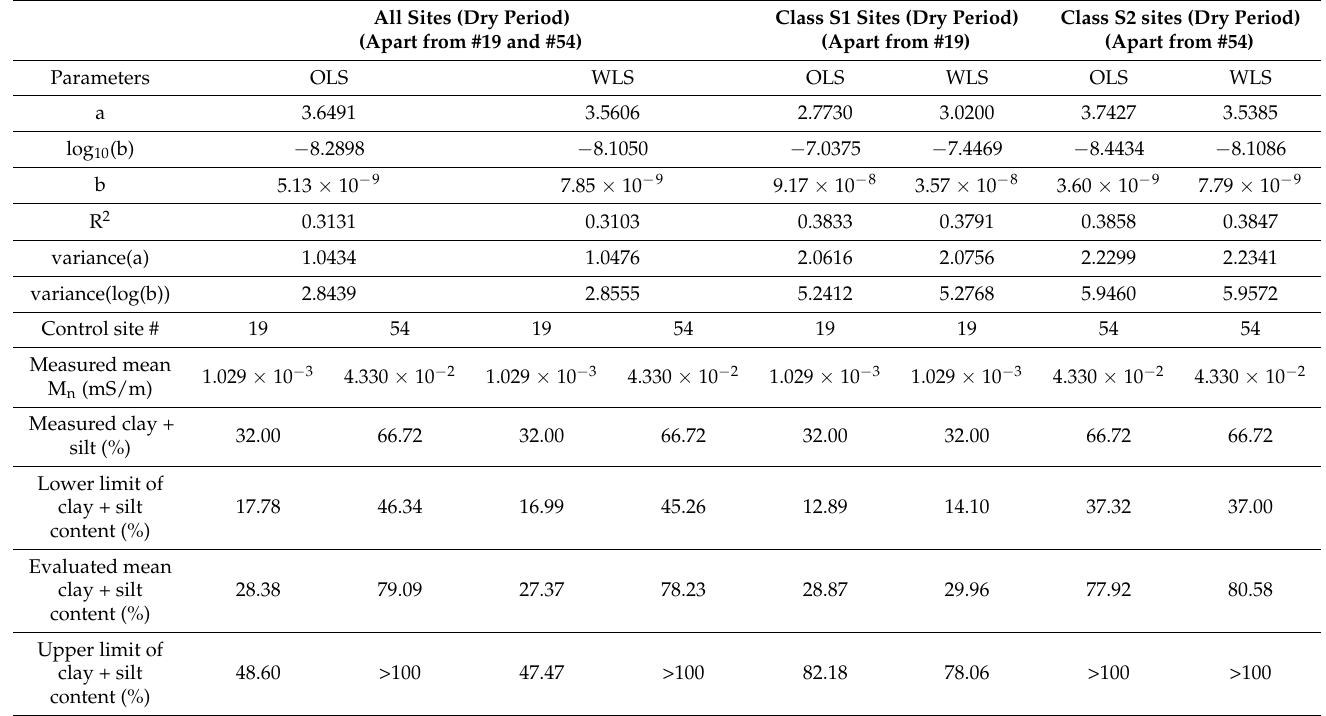
Table 3. Regression parameters and evaluation of the sum of clay and silt content at control sites #19 and #54, using the data from all sites and from sites distributed in classes S1 and S2 deduced from the geological classification of the surveyed